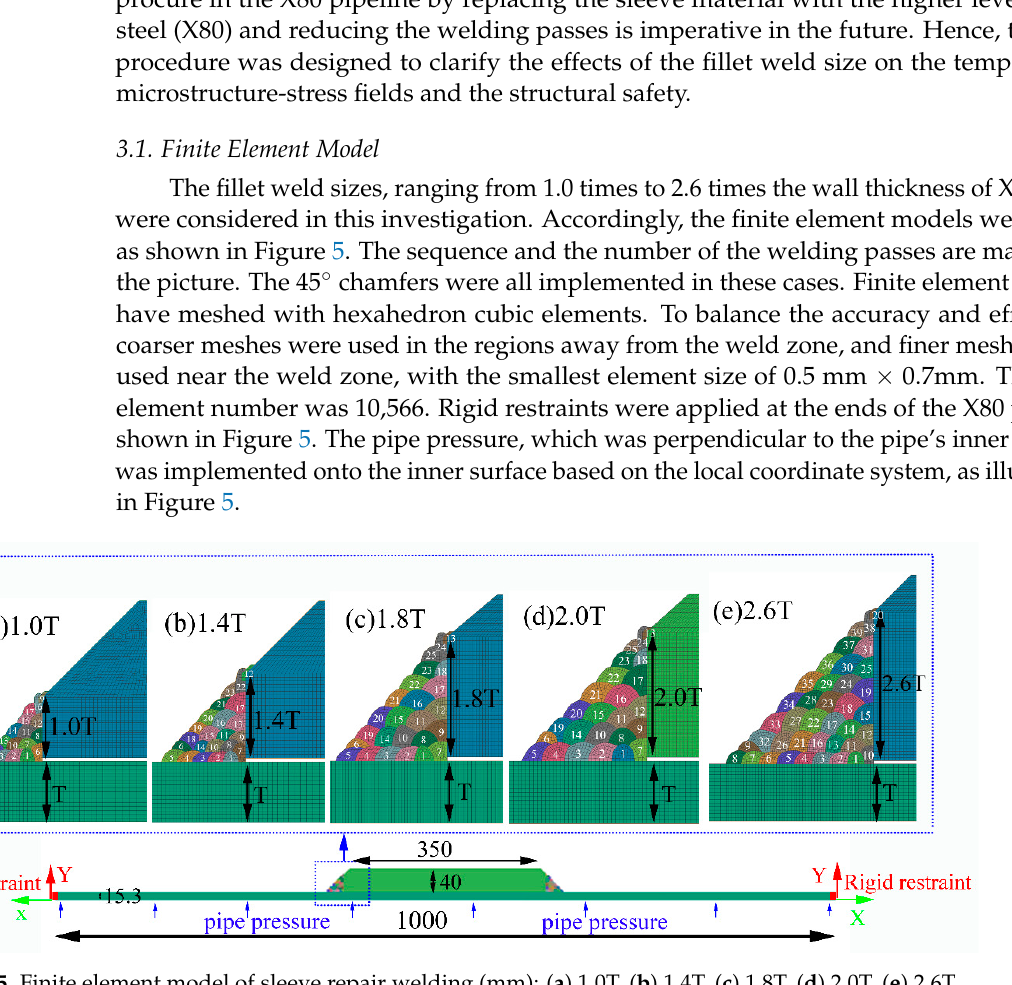
Figure 4. The von Mises stress contour: ( a ) 2D rotational simulation result, ( b ) 3D simulation result.